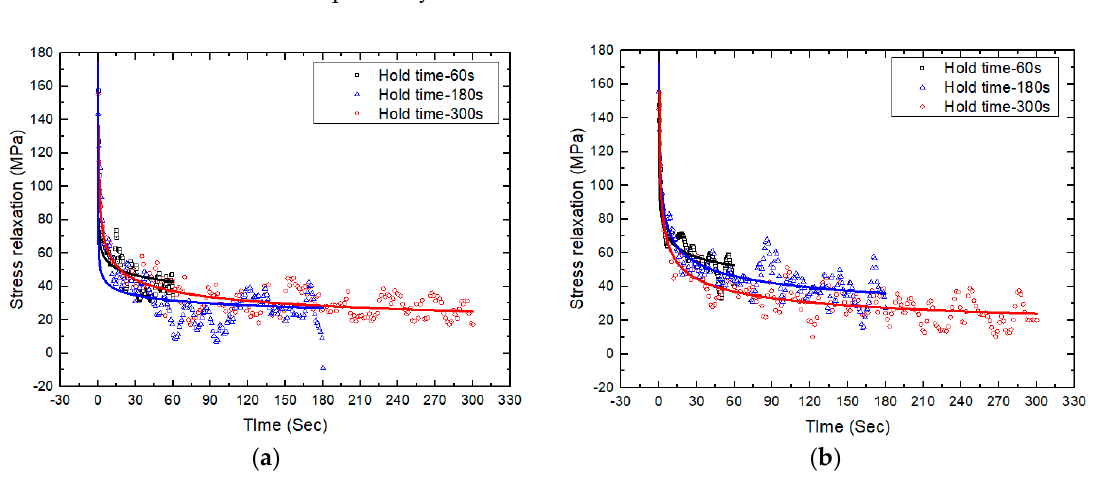
Figure 8. The stress relaxation vs. time curves of Alloy 617: ( a ) Base metal; ( b ) Weldments.